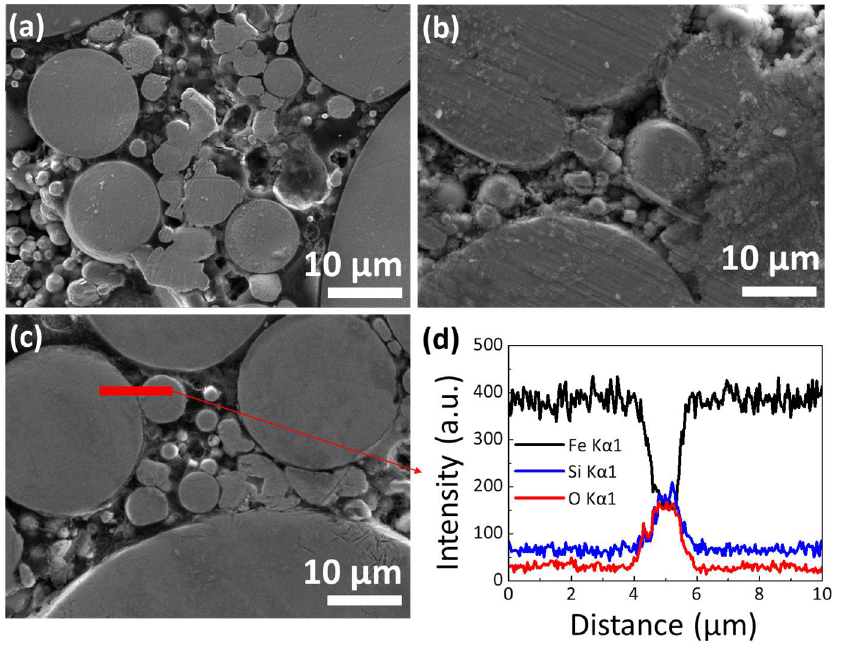
Figure 5. ( a – c ) Cross-section SEM images of ( a ) insulated amorphous SMCs with 20 wt.% CIPs, ( b ) amorphous SMCs with 20 wt.% insulated carbonyl-iron, and ( c ) insulated amorphous SMCs with 20 wt.% insulated CIPs. ( d ) EDS line scan analysis of insulated amorphous SMCs with 20 wt.% insulated CIPs.